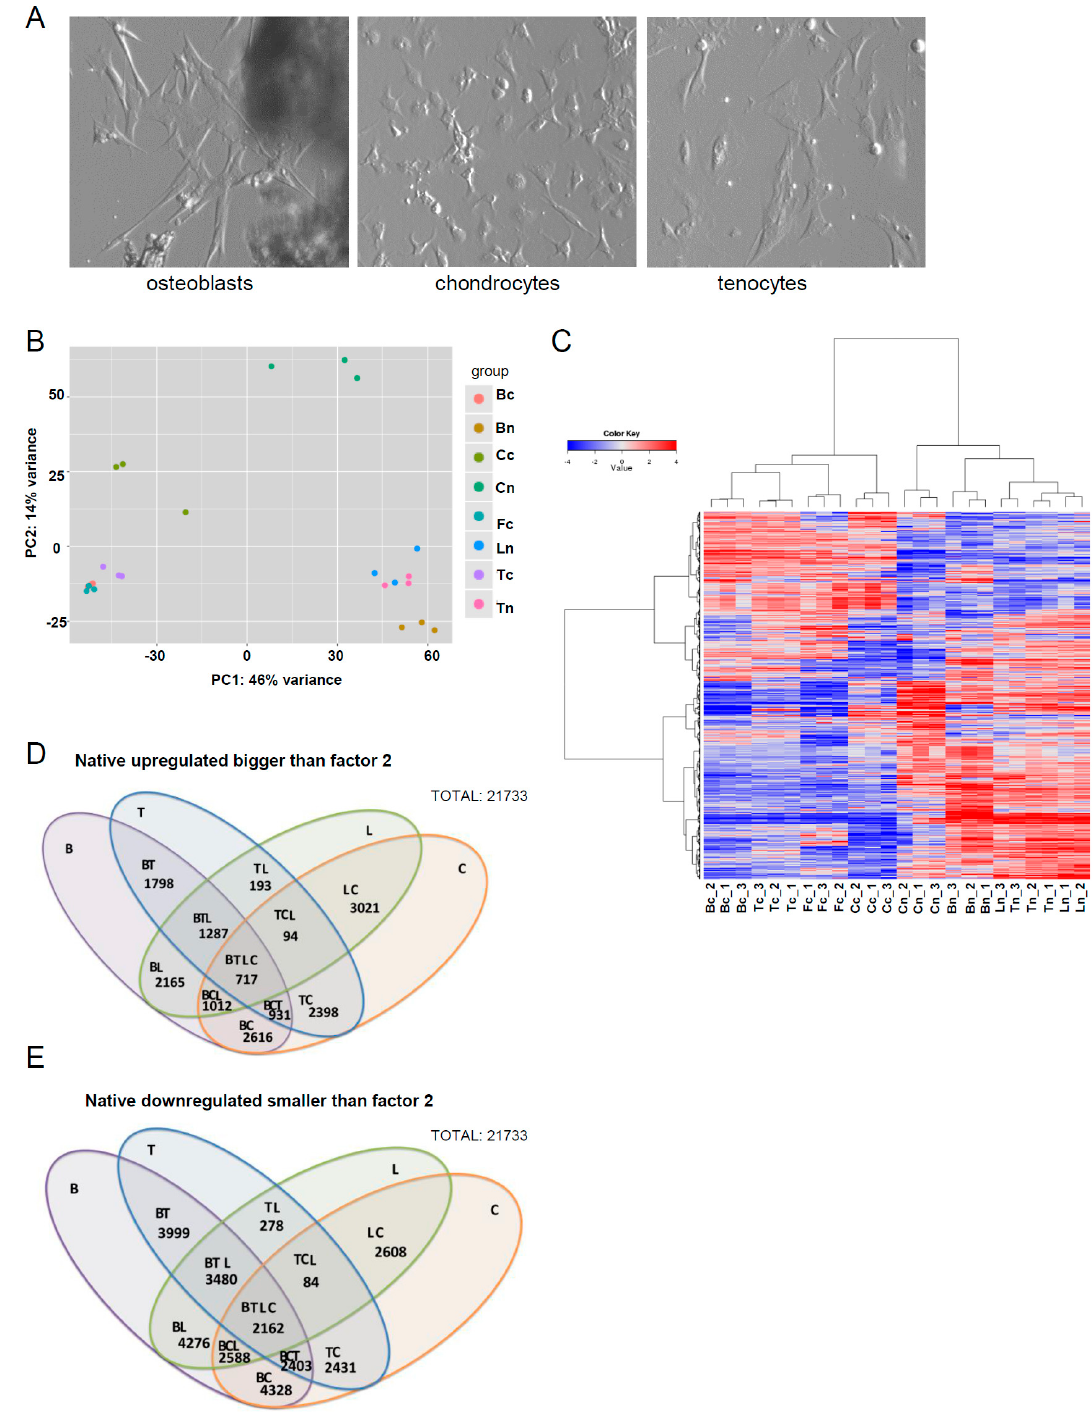
Figure 1. ( A ) Representative phase contrast micrographs of cultured osteoblasts, chondrocytes and tenocytes used for RNA Seq analysis; ( B ) Principal component analysis plot confirming a good separation between most of the tissue types; ( C ) Unsupervised clustering of the top 2000 genes with biggest variance across the samples; ( D , E ) Venn ‐ Diagrams depicting the number of genes up ‐ and down ‐ regulated between all possible comparisons in native tissues. Bc, cultured bone cells; Tc, cultured tendon cells; Fc, cultured fibroblasts; Cc, cultured cartilage cells; Bn, native bone; Tn, native tendon; Ln, native ligament. 1, 2 and 3 refer to the codes of the different horses (n = 3) used in the study.